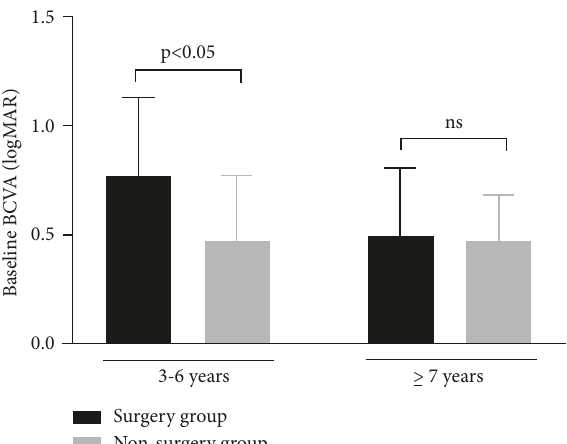
Figure 3: Comparison of baseline best-corrected visual acuity in the surgery group and the nonsurgery group of CEL patients.